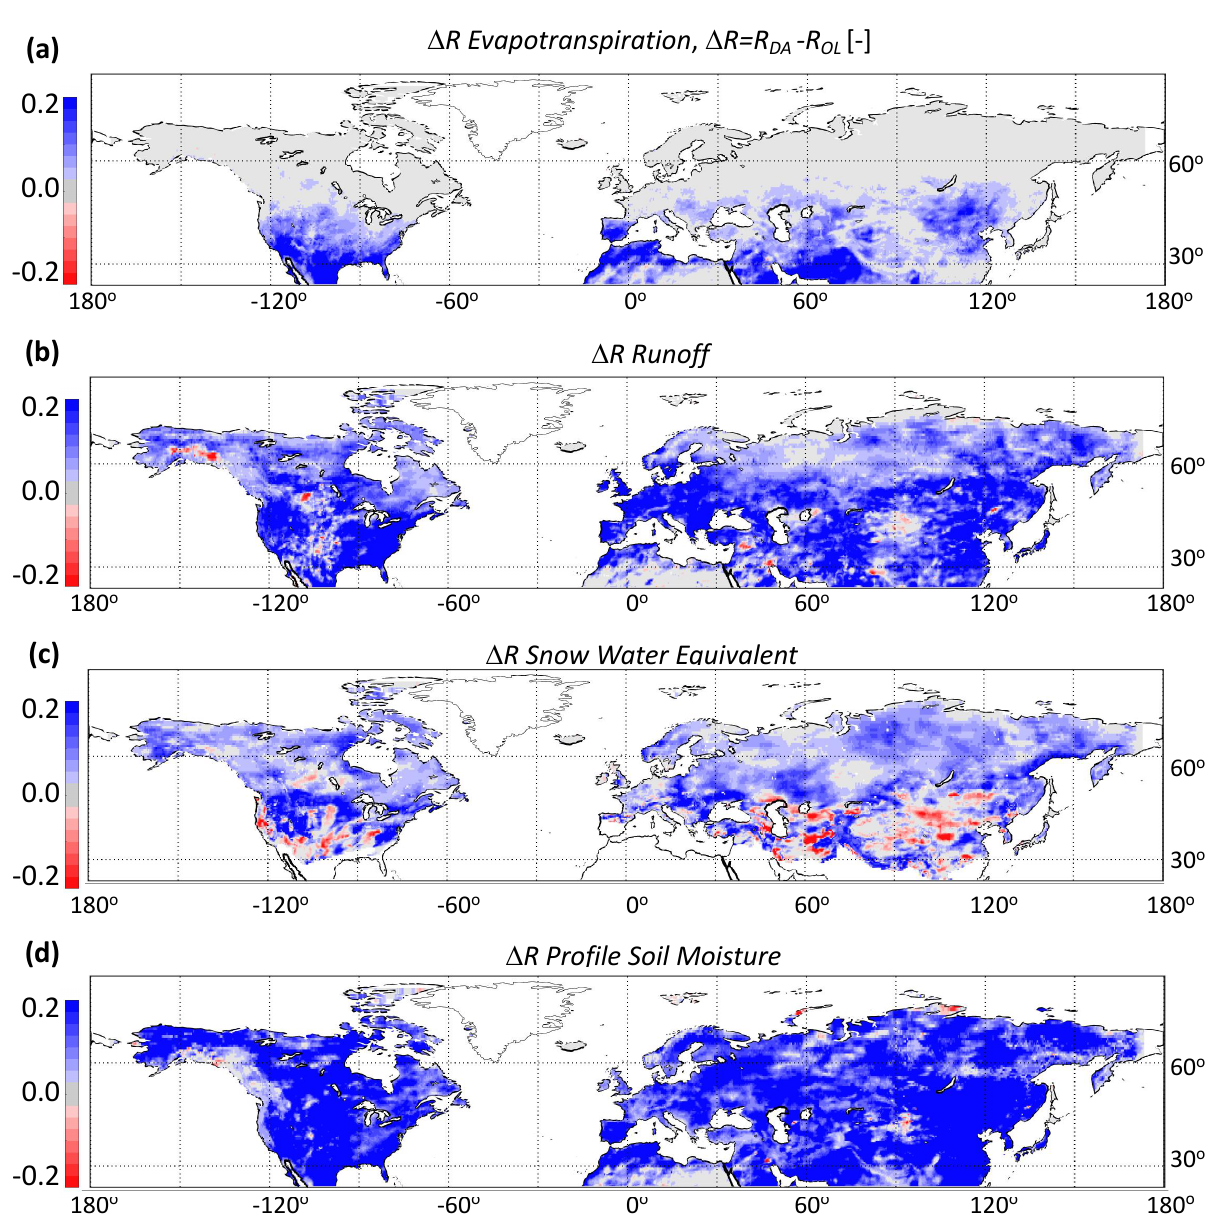
Figure 7. Difference in correlation ( ∆ R ) between data assimilation (DA) and open-loop (OL) for ( a ) Evaporation, ( b ) Runoff, and ( c ) Snow water equivalent; ( d ) profile soil moisture, based on the synthetic simulation. Only snow-possible areas as indicated in ([56]) are reported in ( c